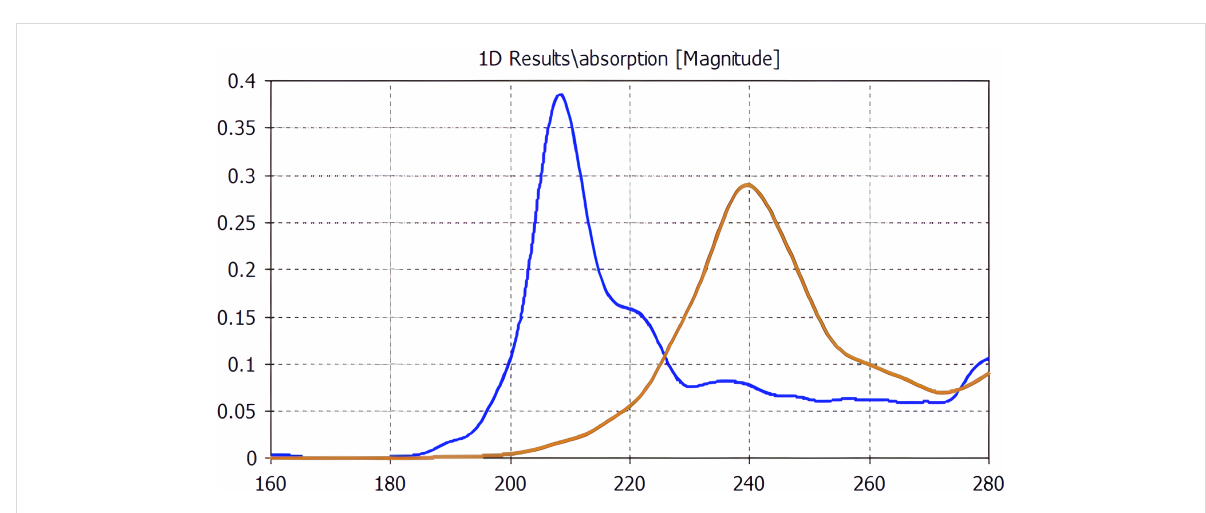
Figure 6: Frequency response of a matrix of receiving cells based on bow-tie antennas for 210 GHz and 240 GHz frequency channels.